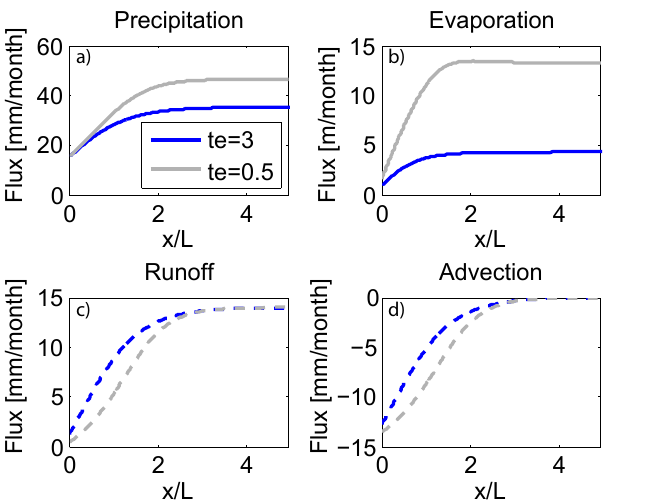
Fig. 5. Effect of faster evaporation on fluxes (default parameter val- ues with W 0 = 0 . 5 and s m = 200mm). Note the different y-scale for precipitation and the negative scale for advection.